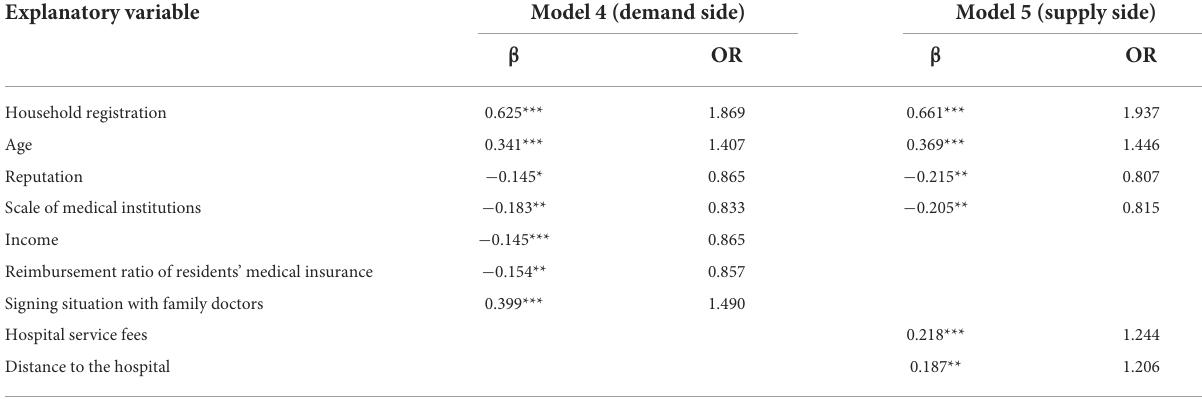
TABLE 4 Regression results of service accessibility on demand side and supply